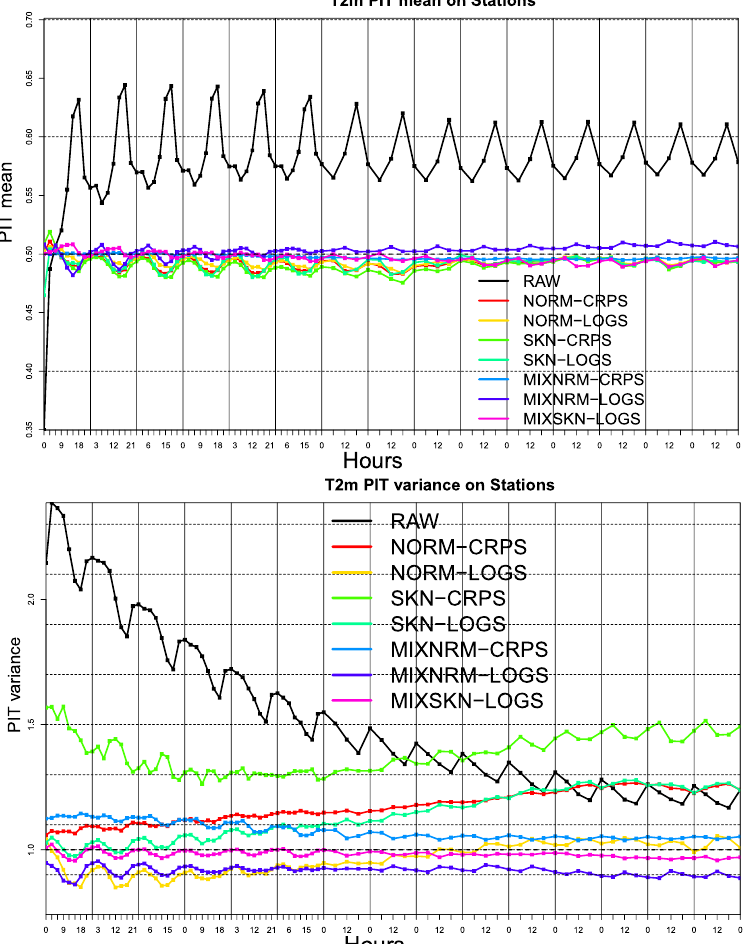
Figure 3. PIT mean and PIT variance for the 2056 weather stations of the benchmark. Subject to calibration, the PIT statistic follows a uniform distribution, its mean is 1 is